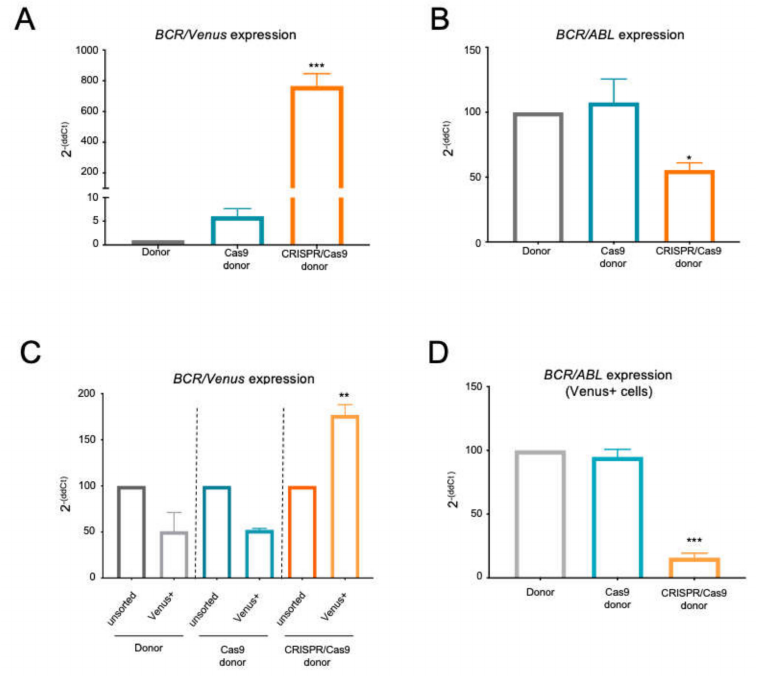
Figure 4. Expression analysis of targeted BCR/ABL locus. ( A ) qPCR of BCR/Venus and ( B ) BCR/ABL in K562 cells electroporated with the CRISPR-Trap system (CRISPR/Cas9 + donor) and controls (donor and Cas9 + Donor). ( C ) qPCR of BCR/Venus expression in electroporated K562 cells, comparing pool and Venus + cells. ( D ) qPCR of BCR/ABL in Venus-positive cells electroporated with the CRISPR- Trap system (CRISPR/Cas9 + Donor) and controls (donor and Cas9 + donor) (mean ± SEM; *, p < 0.05; **, p < 0.01; ***, p <